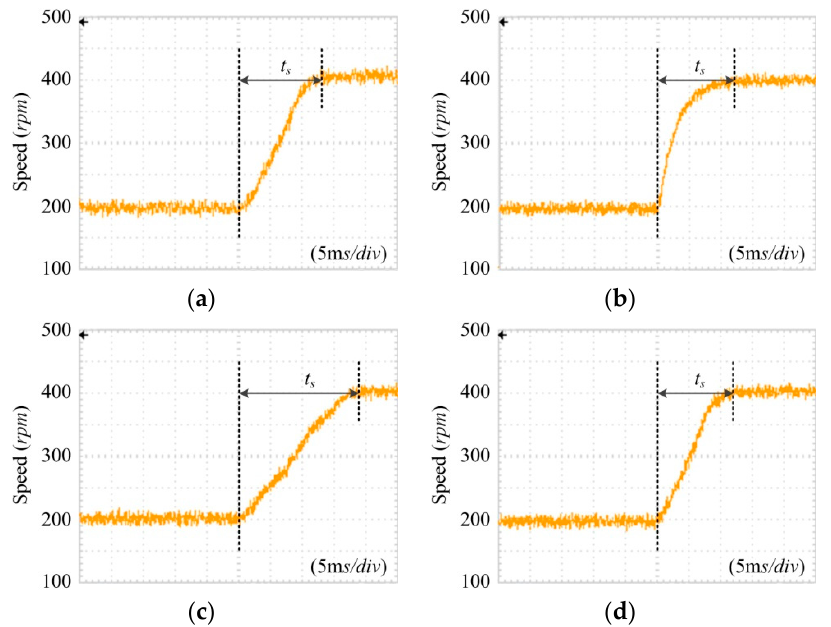
Figure 13. The speed trajectory from 200 rpm to 400 rpm when using: ( a ) CDTC; ( b ) DDTC; ( c ) SVM-DTC; ( d ) CVM-DTC.